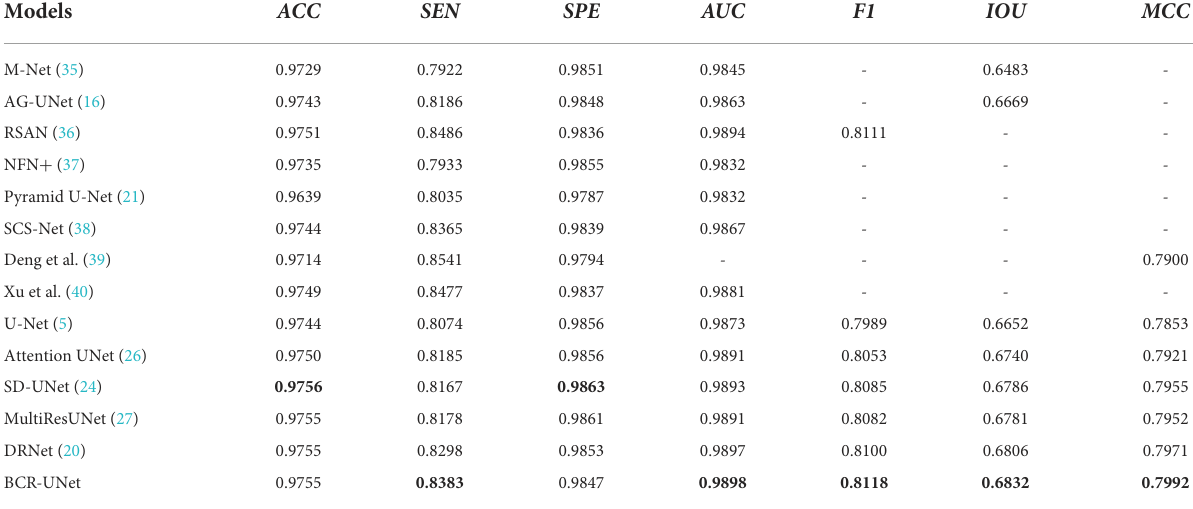
TABLE 6 Results of BCR-UNet and other methods on CHASE DB1